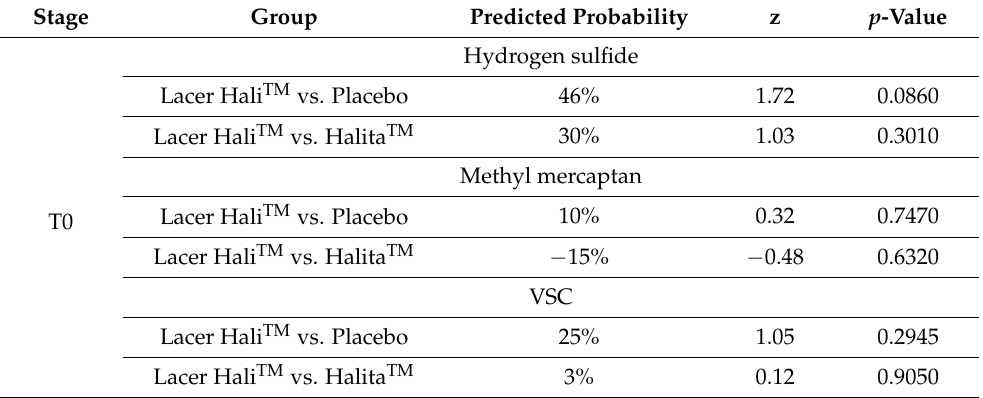
Table 4. Cumulative logit mixed model fitted to evaluate the difference between Lacer Hali TM vs. Halita TM and Lacer Hali TM vs. placebo at different time points in the evaluation of the concentration of hydrogen sulfide, methyl mercaptan, and VSCs.